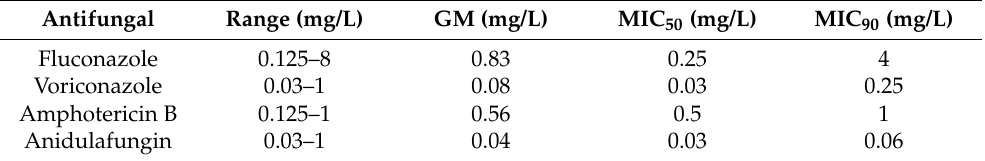
Table 1. MIC ranges, GM, MIC 50 , and MIC 90 values found performing microbroth dilution for 24 h according to the CLSI M27-S4 standard. MIC, minimal inhibitory concentration; GM, geometric mean. Antifungal